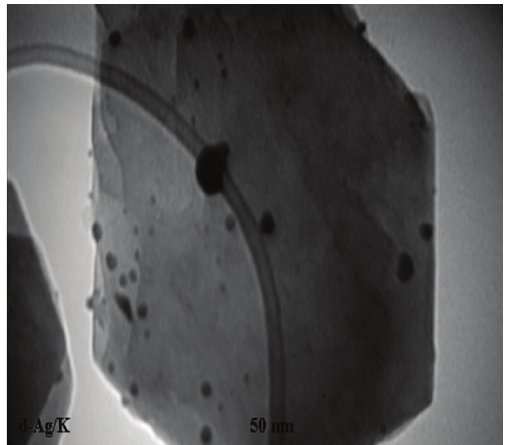
Figure 5: TEM image of Kaolin/Ag NPs